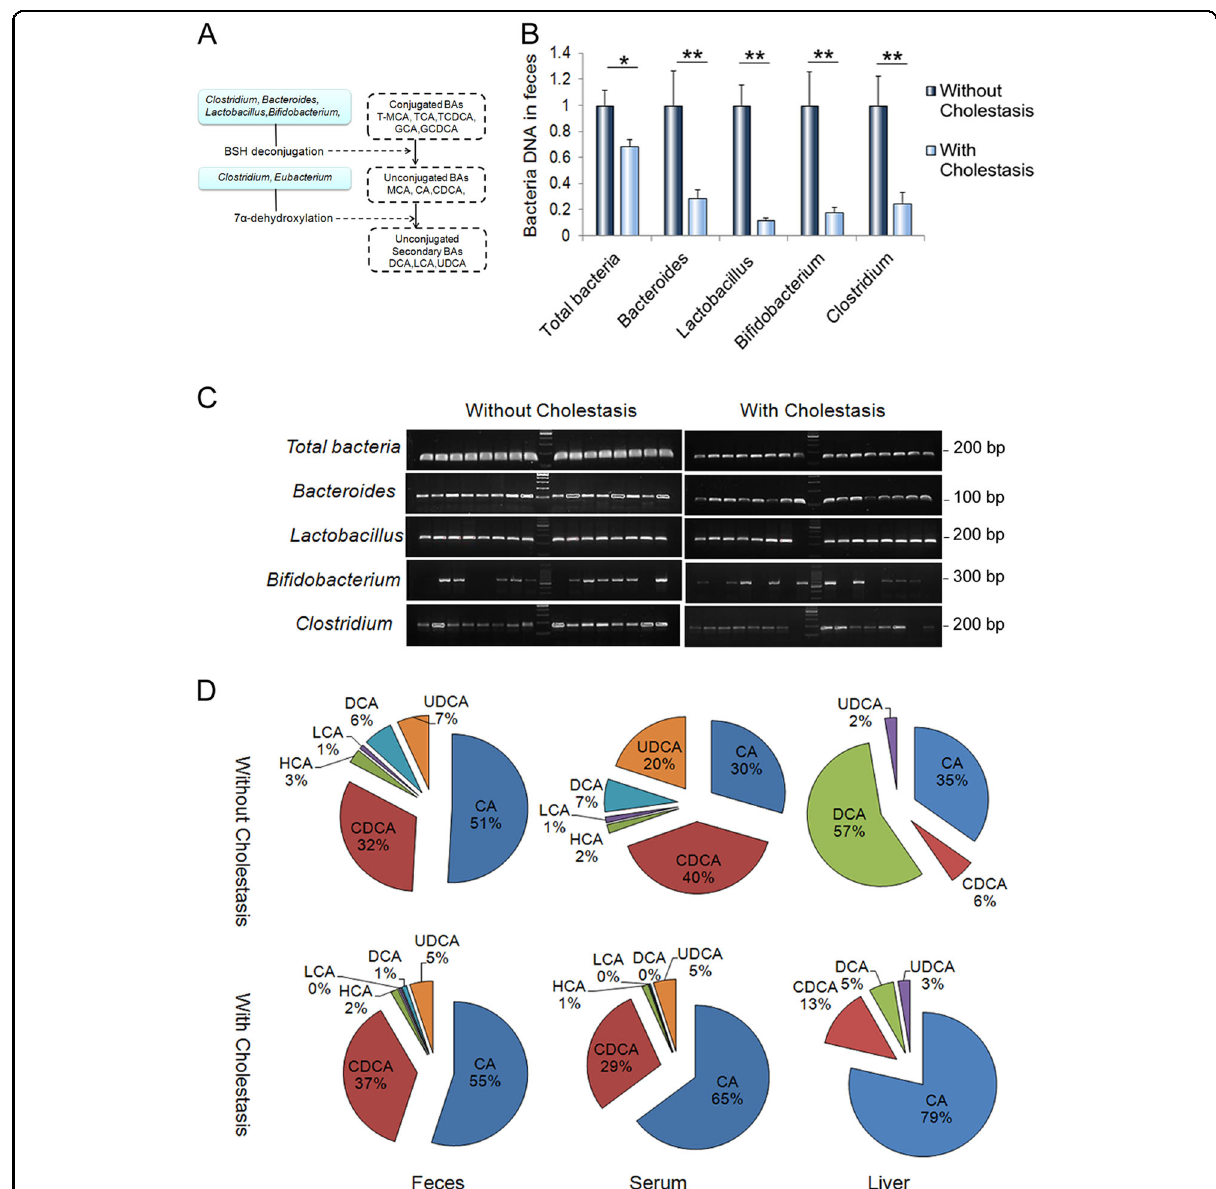
Fig. 1 Intestinal failure (IF) patients with cholestasis exhibit alterations in bile acid (BA)-biotransforming bacteria and BA composition. a Schematic depicting the roles of intestinal bacteria in BA metabolism. b , c The abundances of BA-biotransforming bacteria in the feces of patients with cholestasis (n = 16) were signi fi cantly lower than those in the feces of subjects without cholestasis ( n = 16). d Changes in the BA composition in serum (without cholestasis, n = 26, with cholestasis, n = 20), feces (without cholestasis, n = 16, with cholestasis, n = 16) and liver tissue (without cholestasis, n = 12, with cholestasis, n = 8). * p < 0.05, ** p <